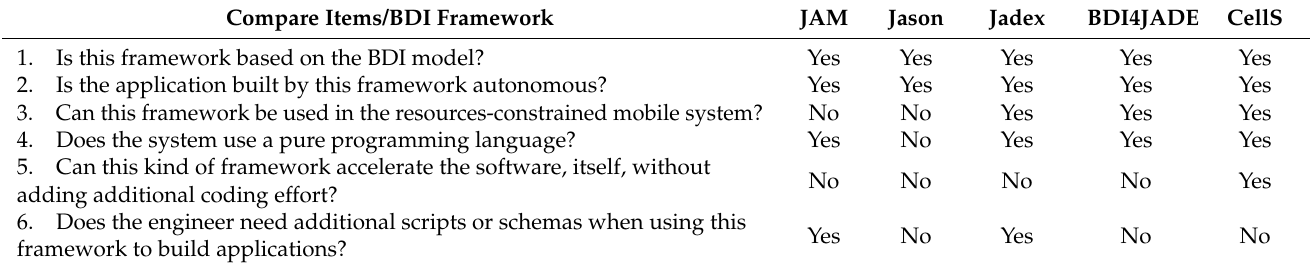
Table 2. This is the comparison of BDI